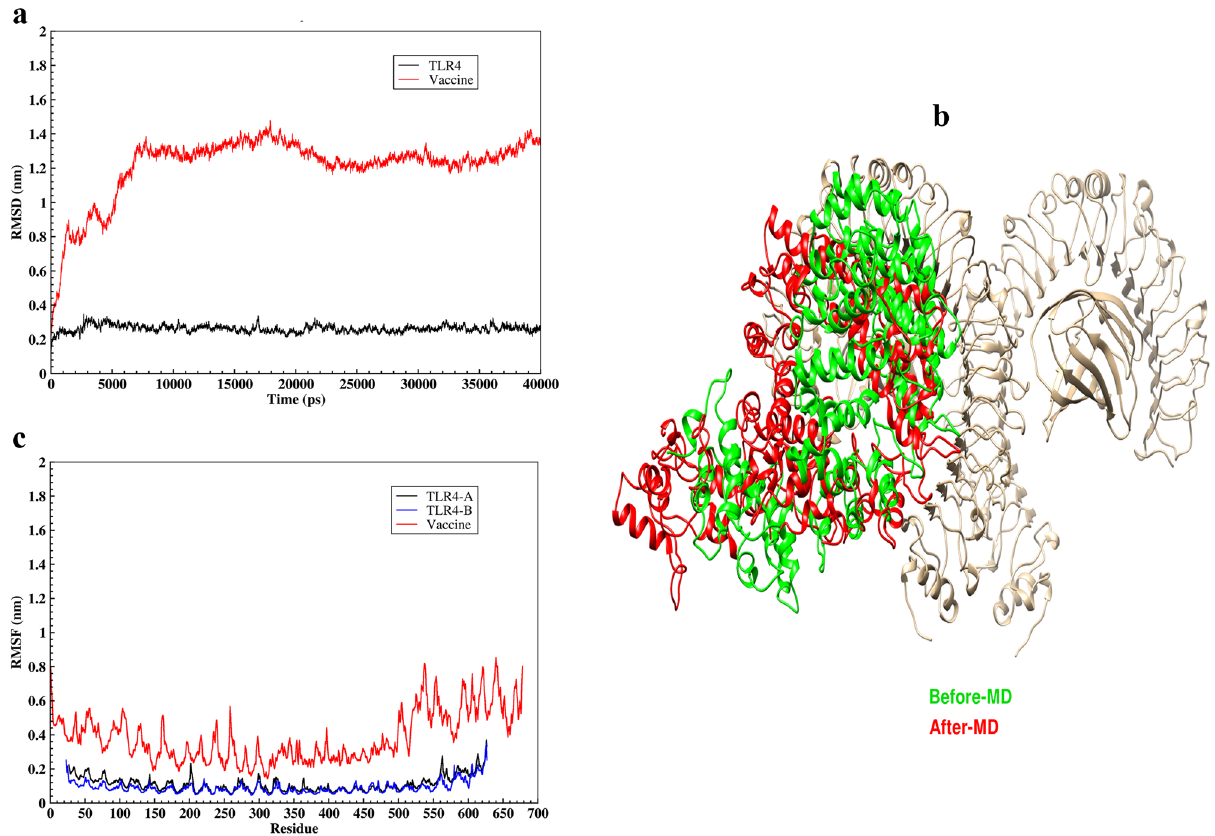
Figure 6. Molecular dynamics simulation analysis of the vaccine–TLR4 complex. ( a ) RMSD plot of the vaccine and TLR 4 in the docked complex for a time duration of 40 ns. ( b ) Conformational changes of the vaccine in the docked complex before (green) and after (red) molecular dynamics simulation was visualized using the UCSF UCSF Chimera 1.15rc software. ( c ) RMSF plot of the vaccine and TLR 4 in the docked